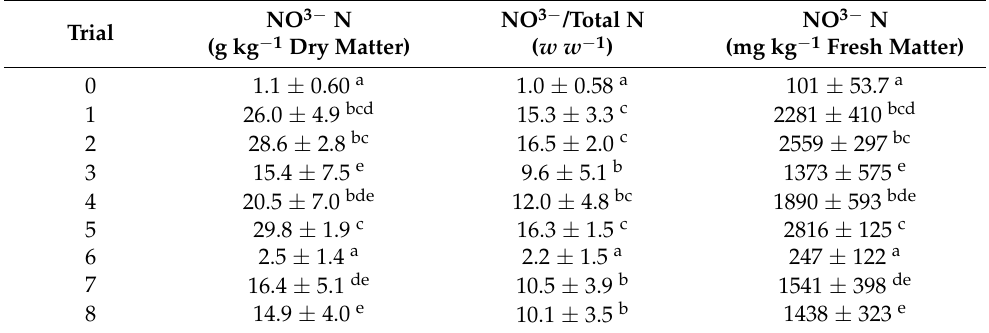
Table 5. Nitric nitrogen (mean value ± standard deviation) 1 in spinach leaves cultivated in trials